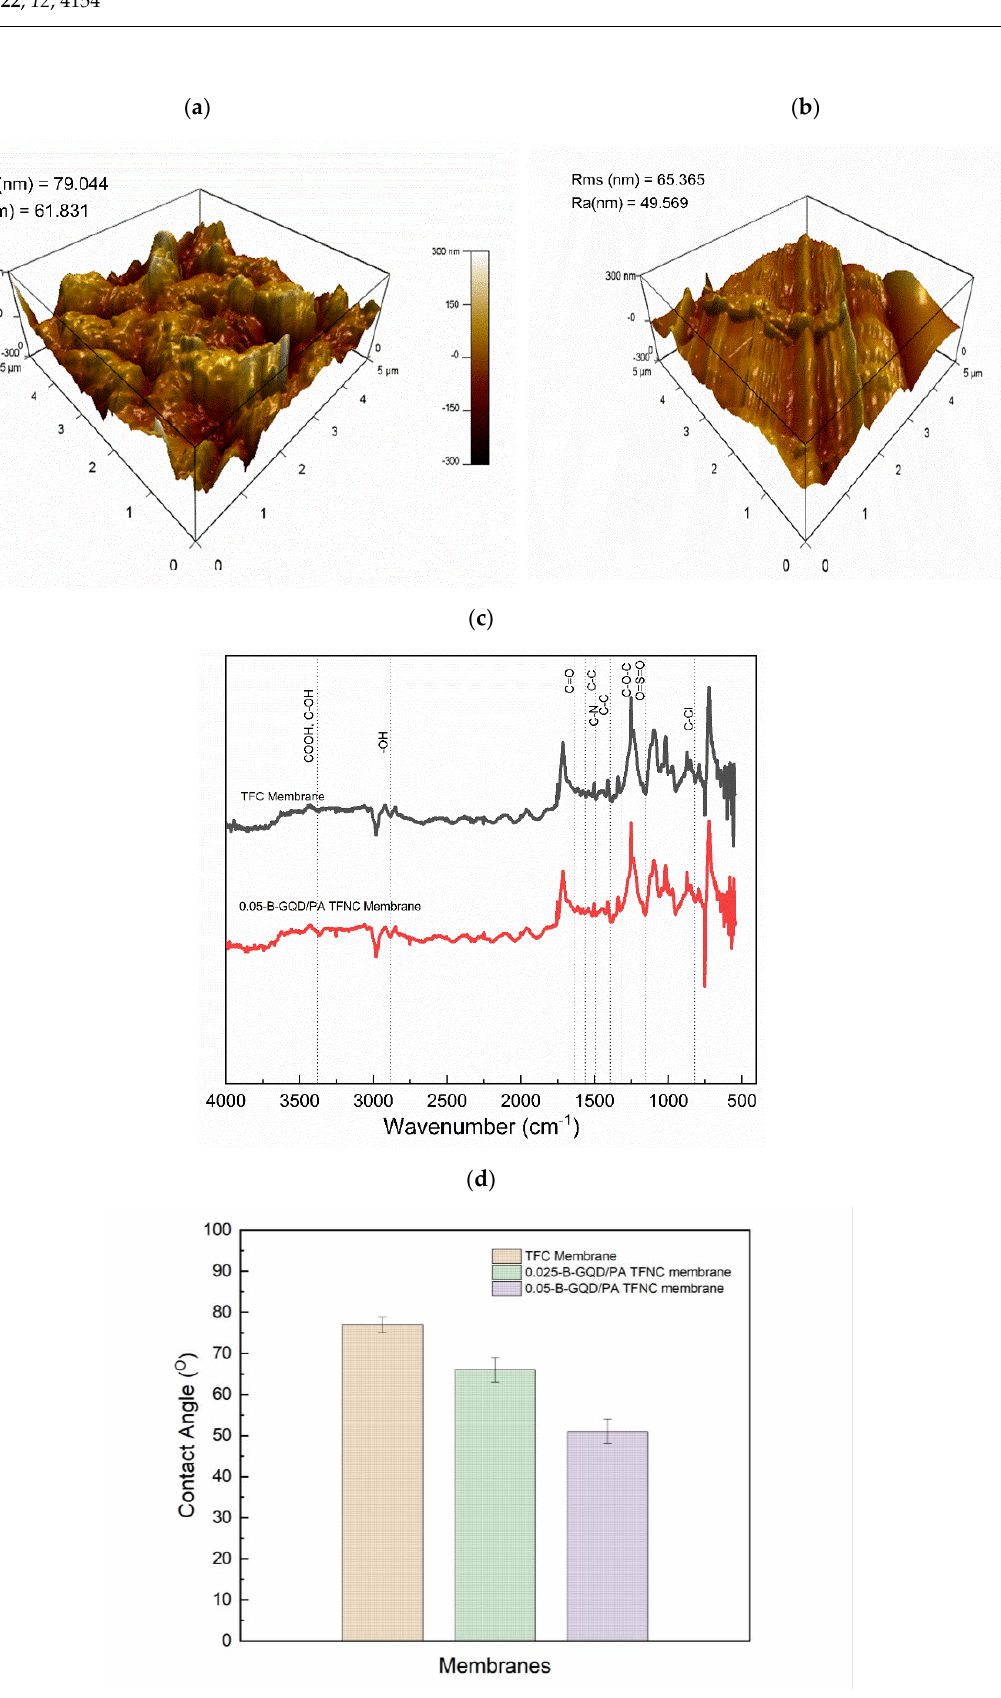
Figure 7. AFM images of ( a ) TFC NFM substrate; ( b ) 0.05-B-GQD/PA TFNC membrane; ( c ) FTIR spectrum of TFC and 0.05-B-GQD/PA TFNC membranes; ( d ) CA analysis of TFC membrane, 0.025-B- GQD/PA TFNC membrane sample, and 0.05-B-GQD/PA TFNC membrane